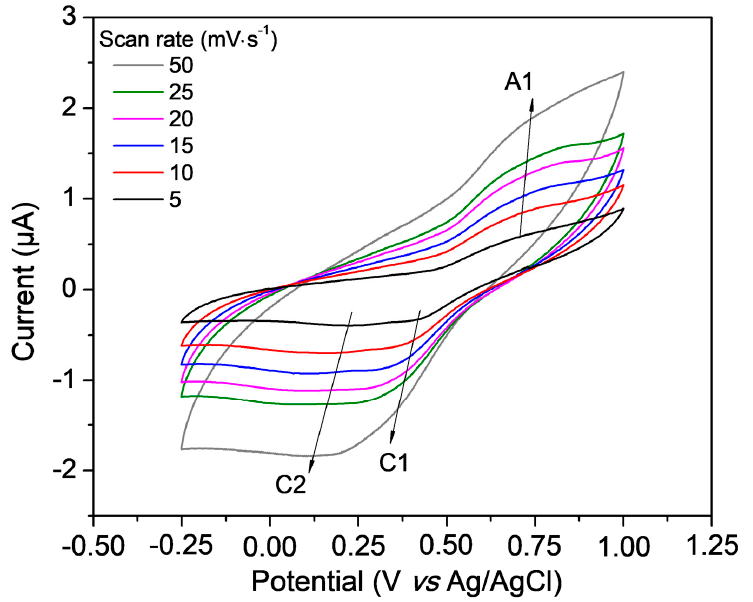
Figure 3. Cyclic voltammograms of catechol end-functional PLLA (drop-casted on a GC electrode) in 0.1 M HClO 4 aqueous solution at various scan